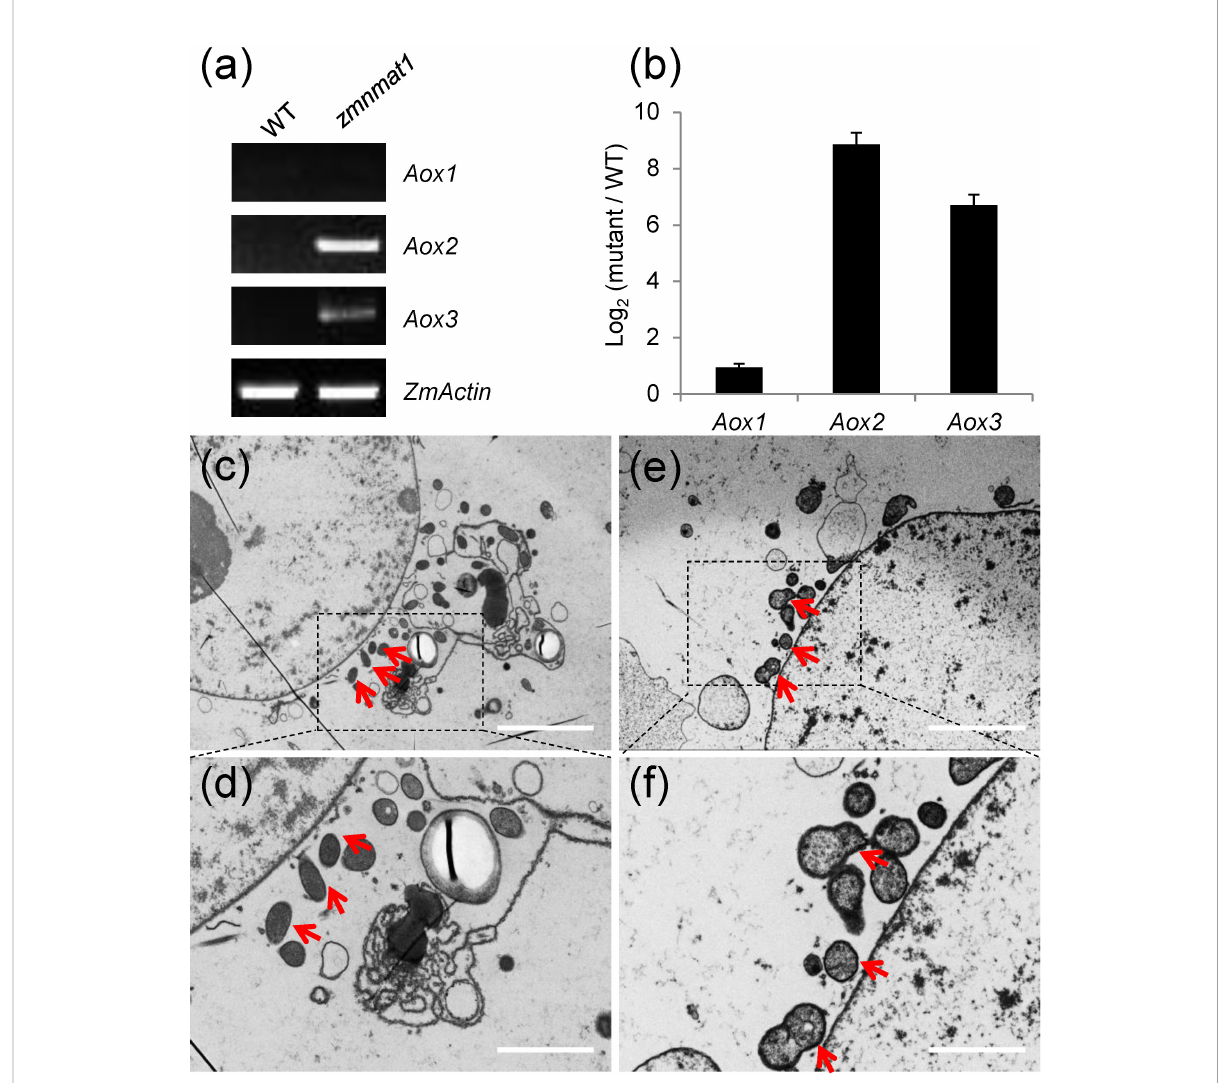
FIGURE 8 Expression of Aox1 , Aox2 , and Aox3 in the zmnmat1 mutant. (A) RT-PCR analysis of Aox1 , Aox2 , and Aox3 expression in the 10 DAP WT and zmnmat1 kernels. The expression level was normalized against ZmActin . (B) qRT-PCR analysis of Aox1 , Aox2 , and Aox3 expression using ZmActin as an internal control. Data is the average ± S.E. of three biological replicates. (C-F) Transmission electron microscopy image of the WT (C, D) and zmnmat1 mutant (E, F) in 15 DAP endosperm cells . (C, E) Low magni fi cation. Scale bar=5 m m. (D, F) High magni fi cation. Scale bar=2 m m. Red arrows indicate the